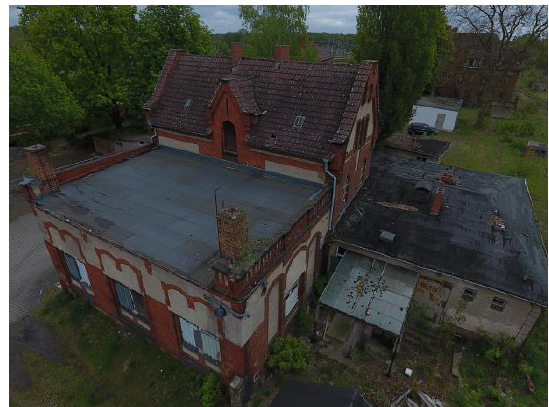
Figure 2. A rather complex building structure in difficult surrounding. Strong vegetation and uneven ground complicate the data